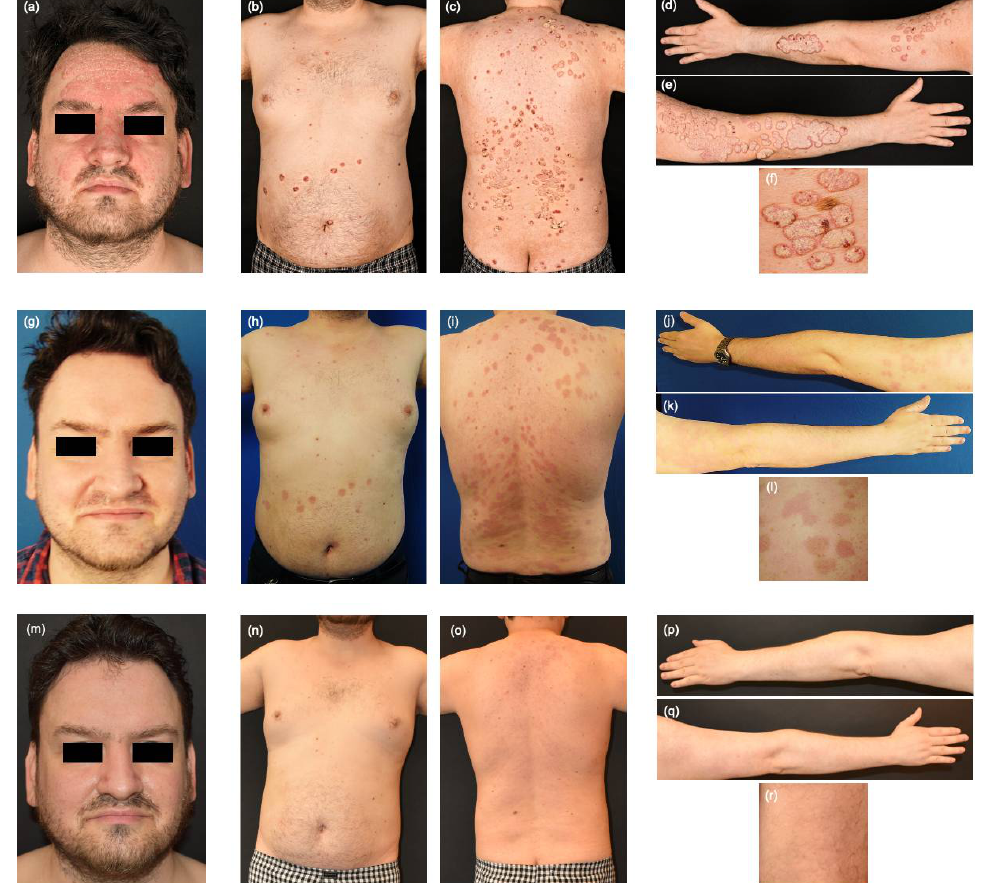
Figure 1. Widespread well-demarcated erythematosquamous plaques on the face and hairy scalp, trunk and upper extremities ( a – e ) and representative plaques of the lower extremities ( f ) after 3 months of therapy with ixekizumab, topical therapy and UVB phototherapy (PASI 16.4; DLQI 16). Complete remission of psoriasis on the face ( g ) and residual erythematous maculae and descent infiltrated plaques with fine scaling on the trunk, upper and lower extremities ( h – l ) 4 weeks after administration of bimekizumab 320mg (PASI 7.8; DLQI 6). Maintenance of complete remission of face psoriasis ( m ) and clearance of psoriasis of the body ( n – r ) after 12 months of treatment (PASI 0; DLQI